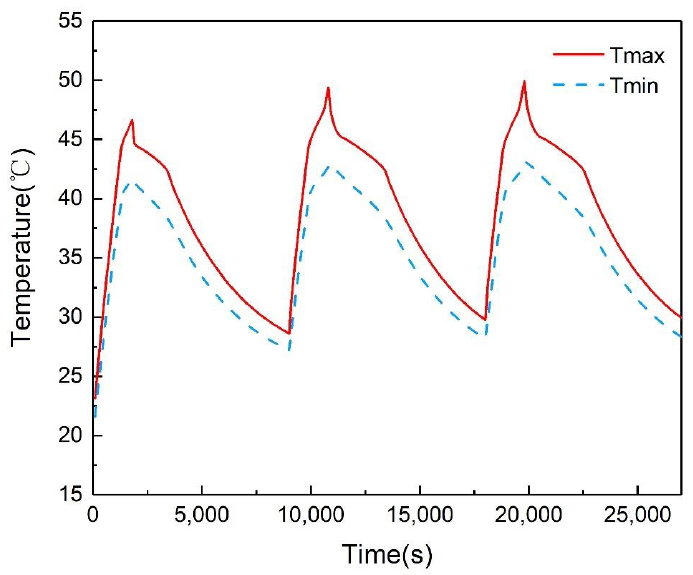
Figure 12. The maximum and minimum temperature curves of a battery pack with a PCM/liquid cold plate module after three consecutive charge and discharge